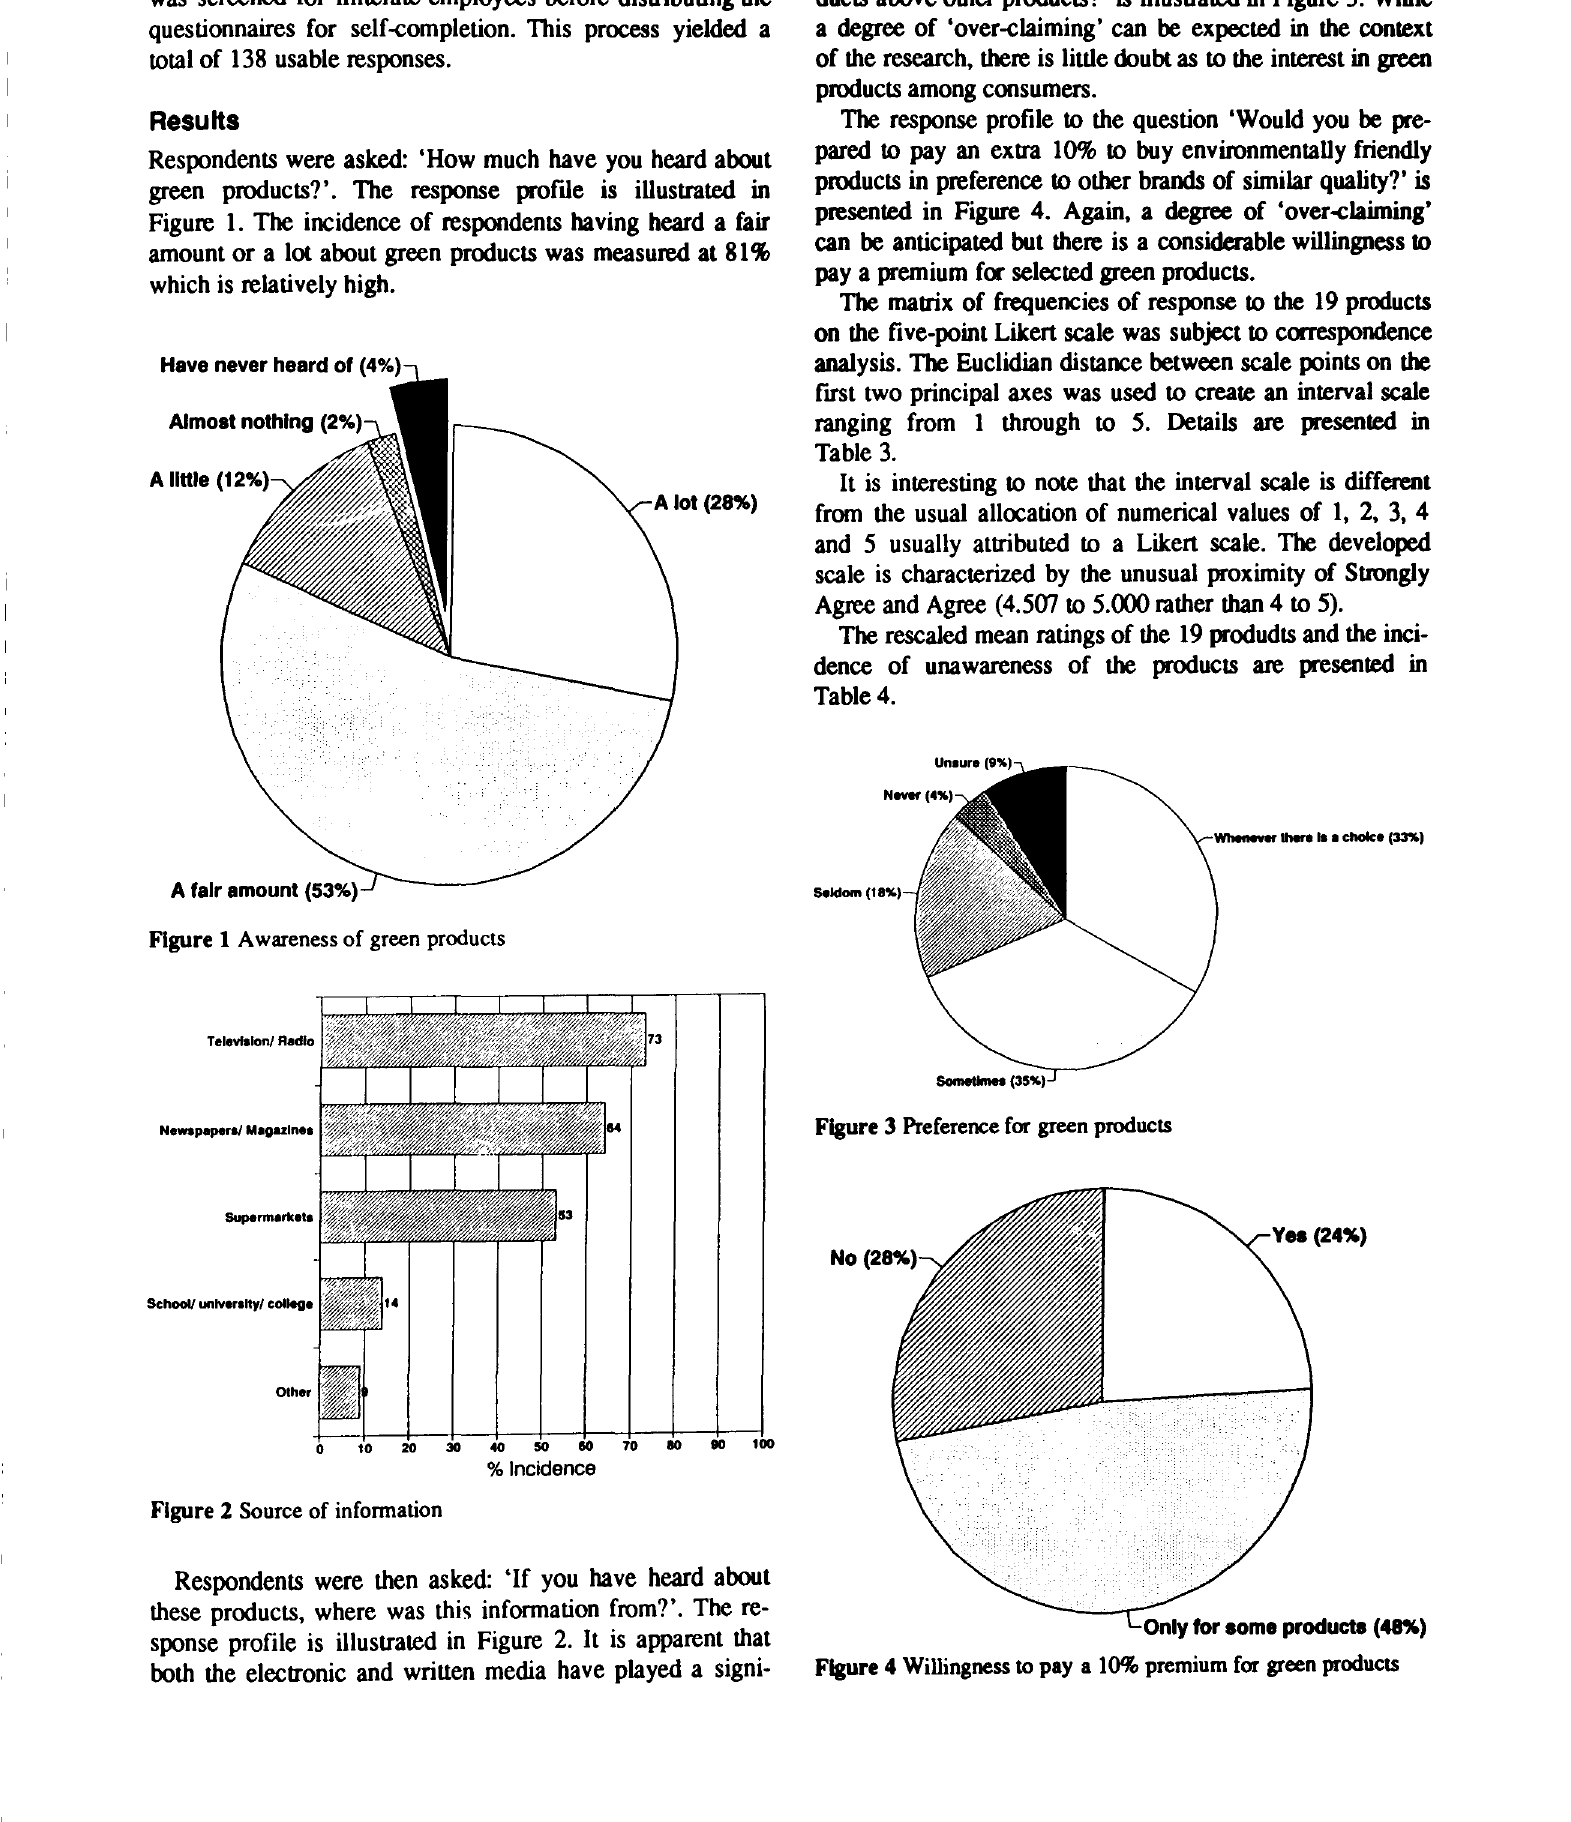
Figure 4 Willingness to pay a 10% premium for green